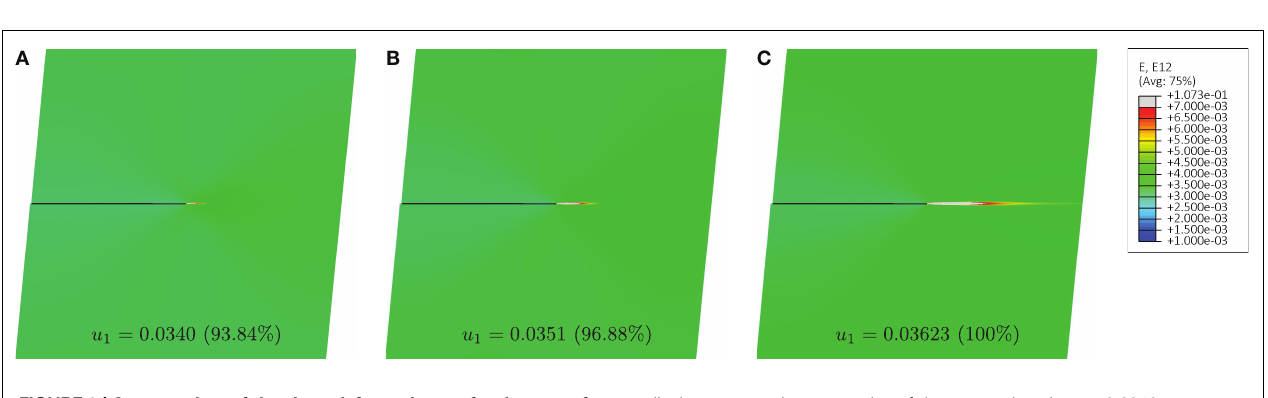
FIGURE 9 | Contour plots of the shear deformation γ 12 for the case of material close to shear band instability ( E p = 300MPa) .Three different stages of deformation are shown, corresponding to a prescribed